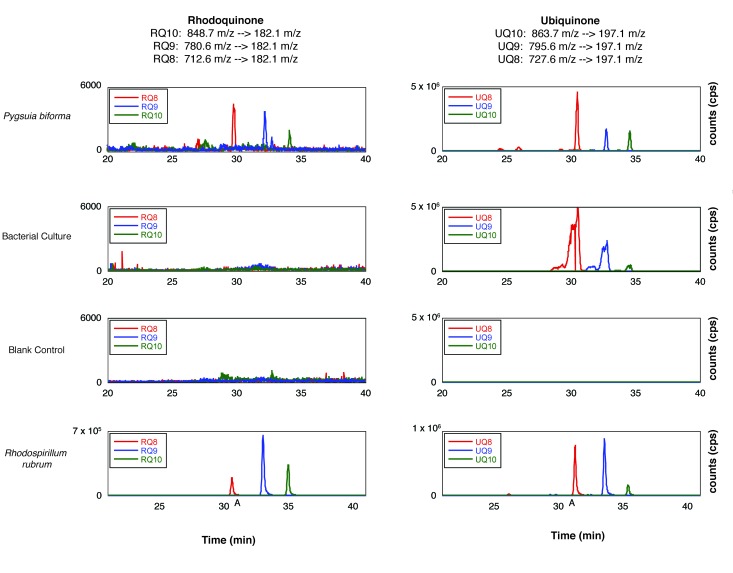
Lipid extracts were separated by high-performance liquid chromatography and analyzed with mixed-reaction monitoring mass spectrometry from Pygsuia mixed culture, Pygsuia ‘food’ bacteria culture, glassware, and Rhodospirillum rubrum as indicated. Spectra represent the elution times of detection of the rhodoquinone head group (182.1 m/z; left) and ubiquinone head group (197.1 m/z) following fragmentation of parent ions of different isoprenyl chain lengths as indicated.